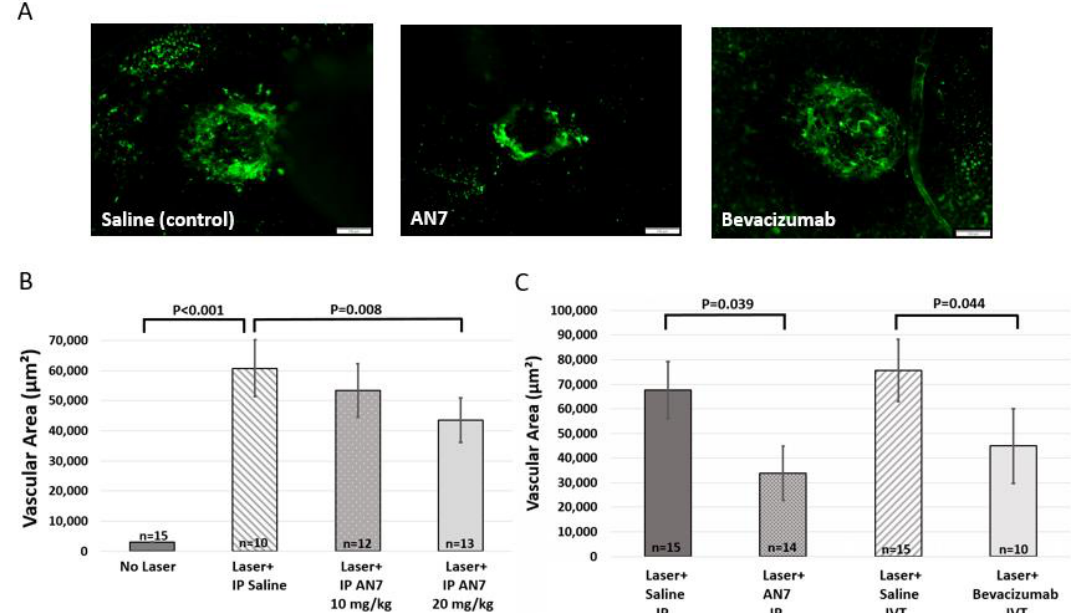
Figure 2. Systemic AN7 treatment reduces choroidal neovascularization (CNV) area. ( A ) Representative images of choroidal flatmounts from day 7 post laser application, with CNV lesions sites from mice treated with saline, AN7 or bevacizumab. Fluorescein isothiocyanate dextran (FITC-dextran) (green) perfused through the blood vessels of the eyes and is seen at the laser lesion site, indicative of CNV formation. Scale bar, 100 µ m. ( B ) Quantification of FITC area in choroidal flatmounts (indicative of CNV area) on day 7 from laser photocoagulation. Three laser applications were performed on the right eyes and mice were randomized to intraperitoneal (IP) 20 mg/kg AN7 or 10 mg/kg AN7 or IP saline-control groups, administered immediately following laser photocoagulation and for a total of three times a week thereafter. One-way ANOVA followed by Sidak post hoc test was used for statistical analysis. n = number of eyes per group. ( C ) Quantification of FITC area in choroidal flatmounts (indicative of CNV area) on day 7 post laser photocoagulation. Three laser applications were performed on the right eyes. IP injections of AN7 were compared to intravitreal (IVT) injection of bevacizumab and to corresponding saline controls. IP injections of AN7 or saline were administered immediately following laser applications and for a total of three times a week thereafter. IVT injections of bevacizumab or saline were administered once, immediately following the laser applications. One-way ANOVA followed by Sidak post-hoc test was used for statistical analysis. n = number of eyes per group.